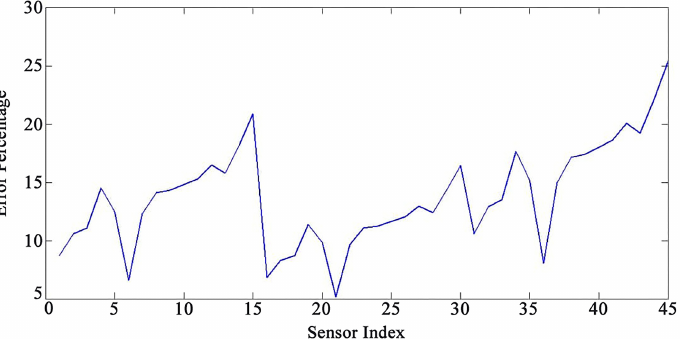
Figure 8. Error percentage for each sensor under loading number 2 (30-degree attack angle).